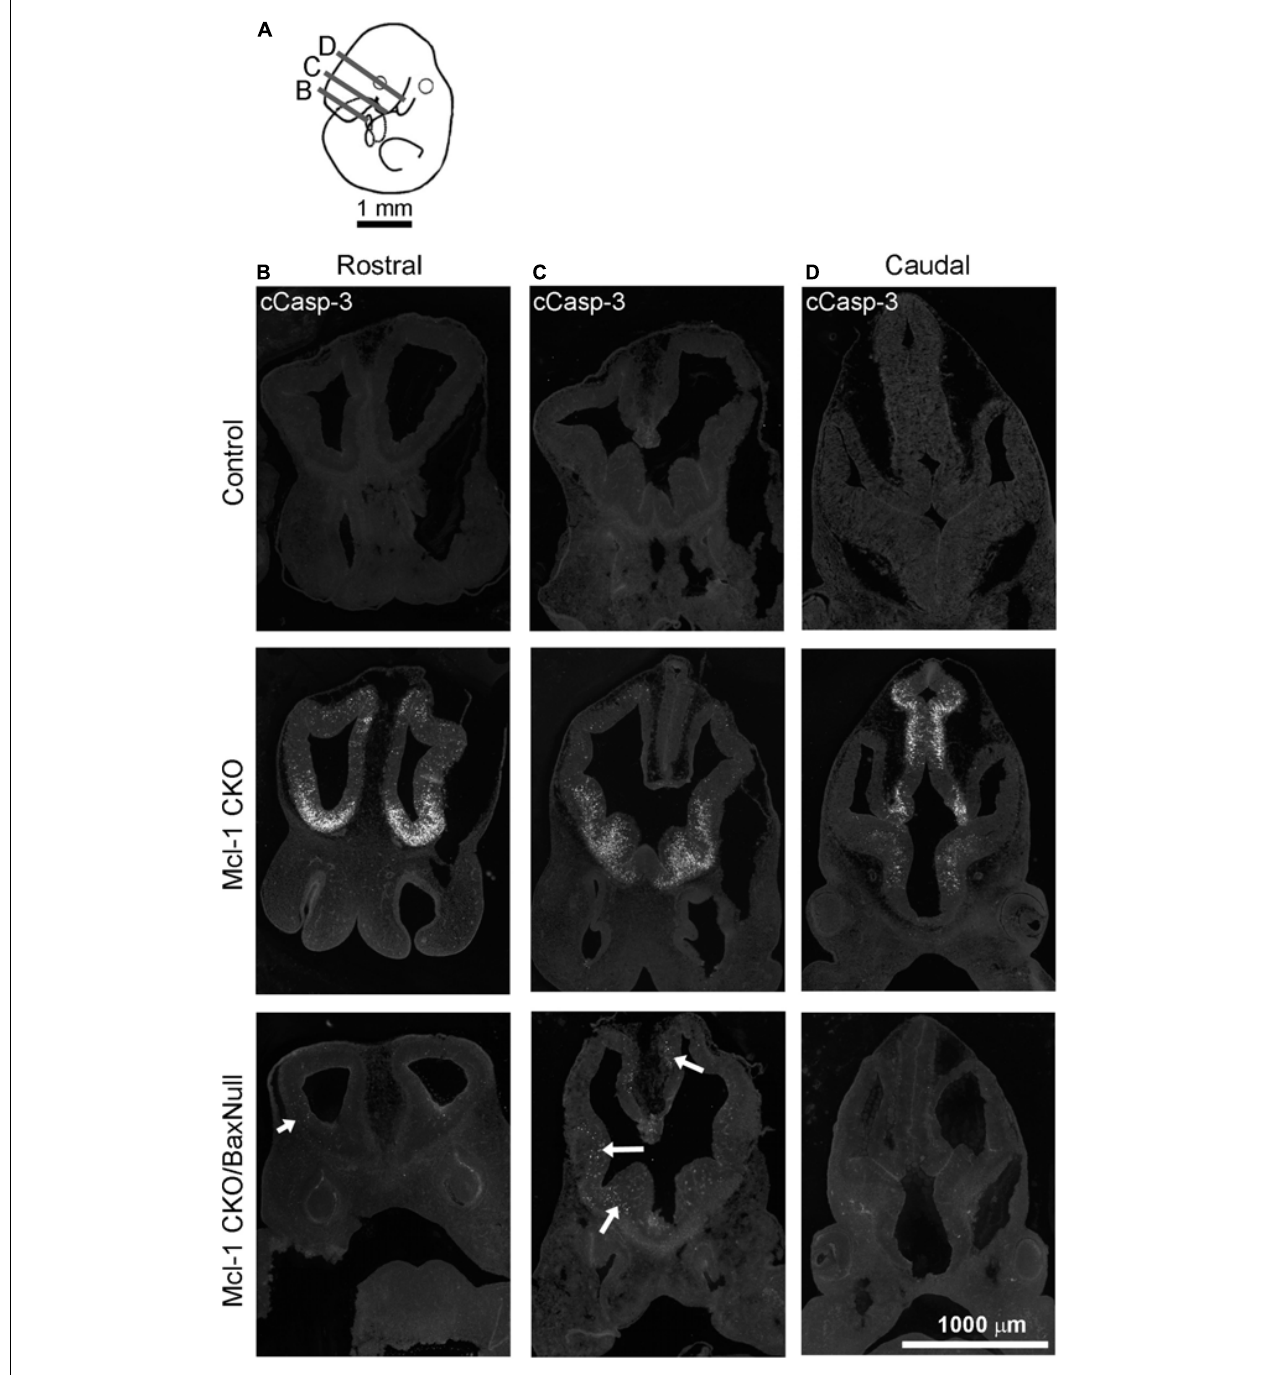
FIGURE 4 | NPC are rescued from apoptotic cell death throughout the developing forebrain of E11 Mcl-1 CKO embryos when Bax is co-deleted. (A) Line drawing of E11 embryo indicating location of coronal sections collected through the rostral to caudal extent of the forebrain. Representative coronal sections immunostained for cCasp-3 taken from the (B) rostral, (C) middle, and (D) caudal portion of forebrains from wild type (Control) ( n = 4), Mcl-1 CKO ( n = 4) and Mcl-1 CKO/BaxNull ( n = 4) embryos. Arrows indicate regions where there are occasional apoptotic cells in the forebrains of Mcl-1 CKO/Bax null